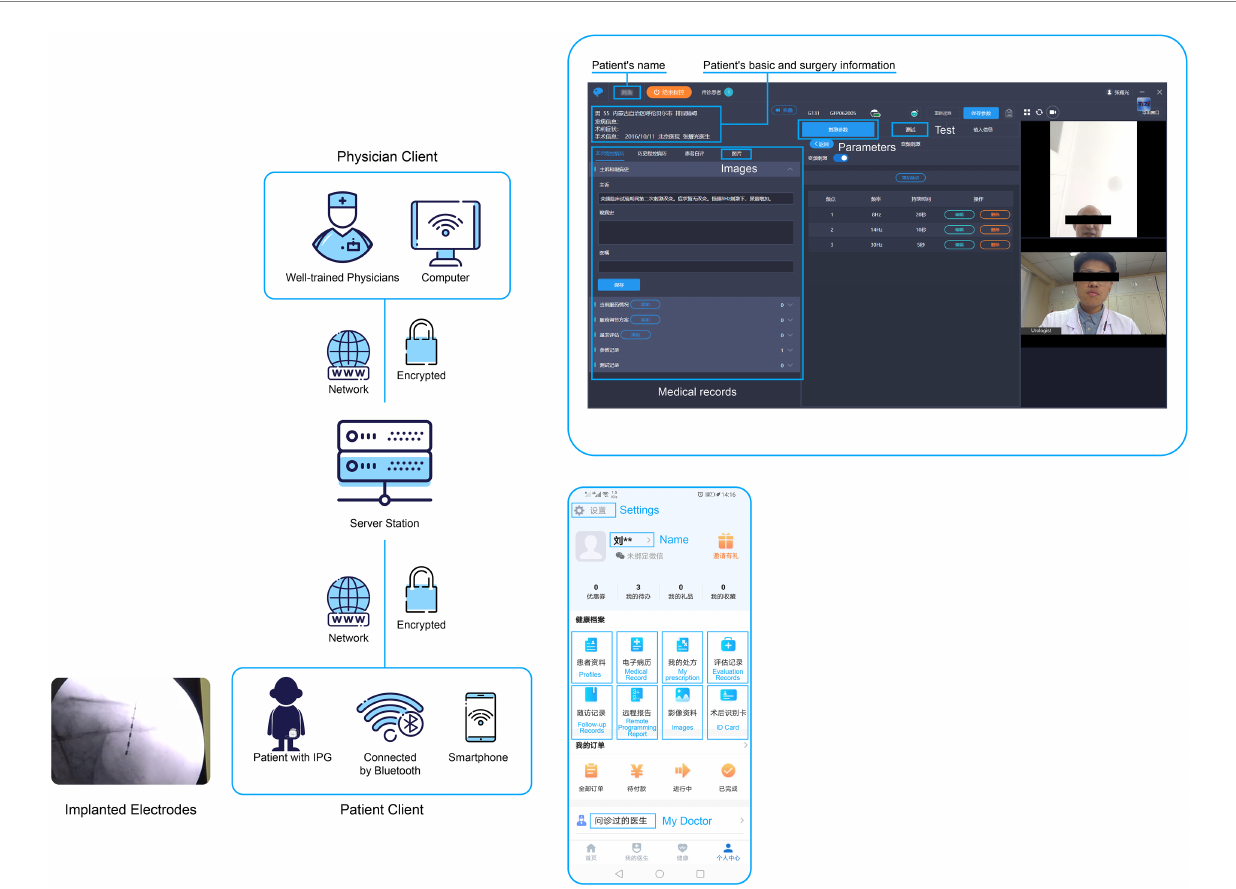
FIGURE 1 Overall architecture of the remote programming system. The remote programming system consists of three parts (“sides”): the doctor, patient, and server sides. The patient and doctor sides are connected with the server side through two different versions of the application. The upper and lower right panels show the doctor and patient versions, respectively, of the